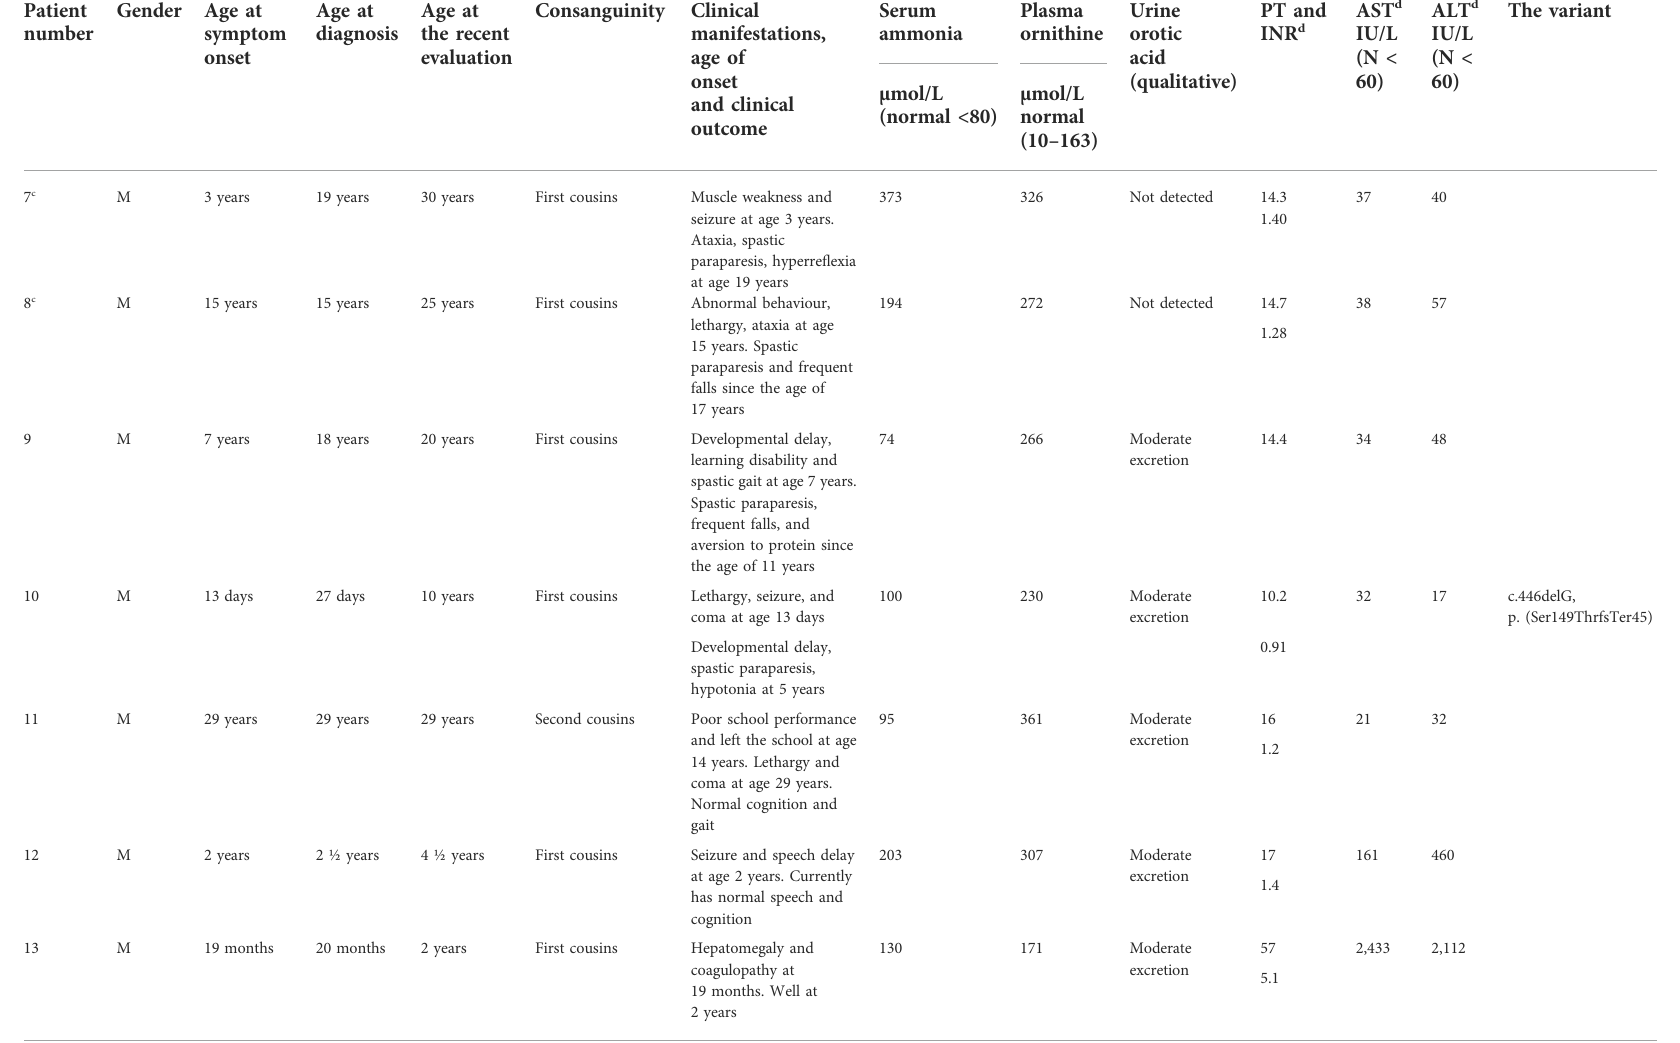
TABLE 1 ( Continued ) Clinical phenotype, biochemical fi ndings, and genotype of patients with HHH syndrome. Patient Gender Age at number